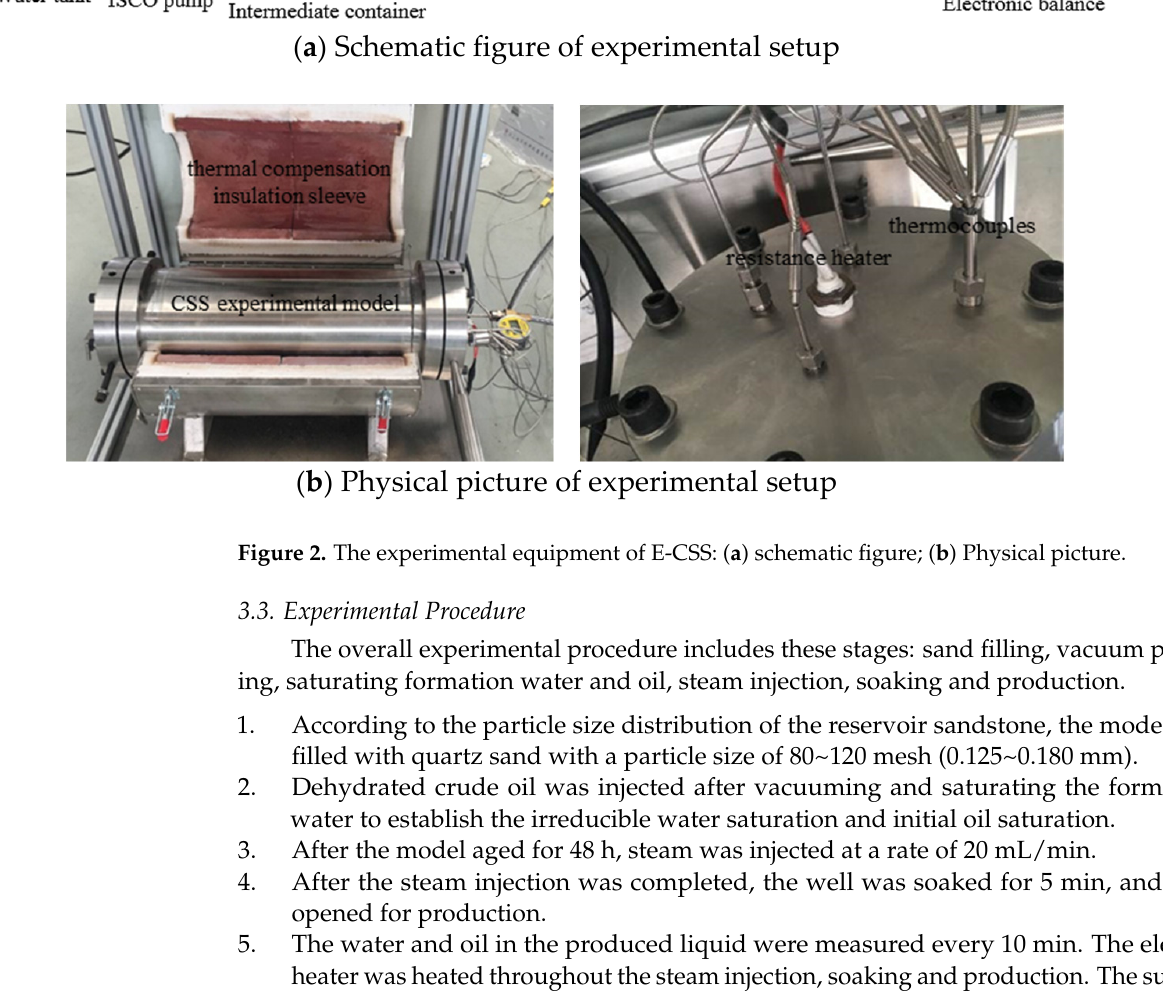
( a ) Schematic figure of experimental setup